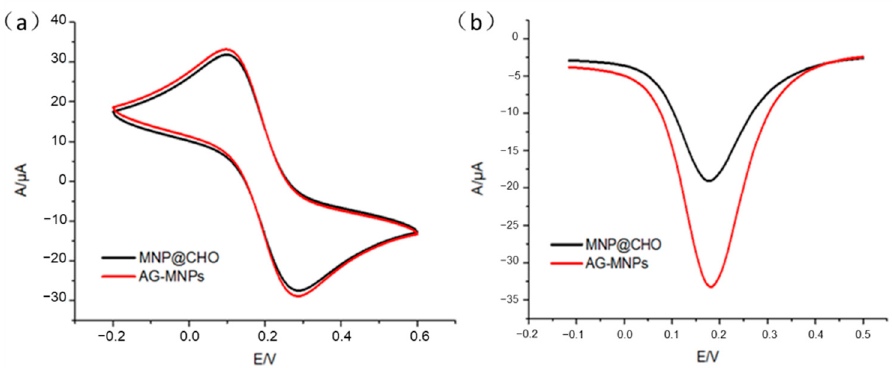
Figure 2. ( a ) Cyclic voltammograms (CV) of CHO-MNPs and AG-MNPs; ( b ) differential pulse voltammograms (DPV) of CHO-MNPs and AG-MNPs.